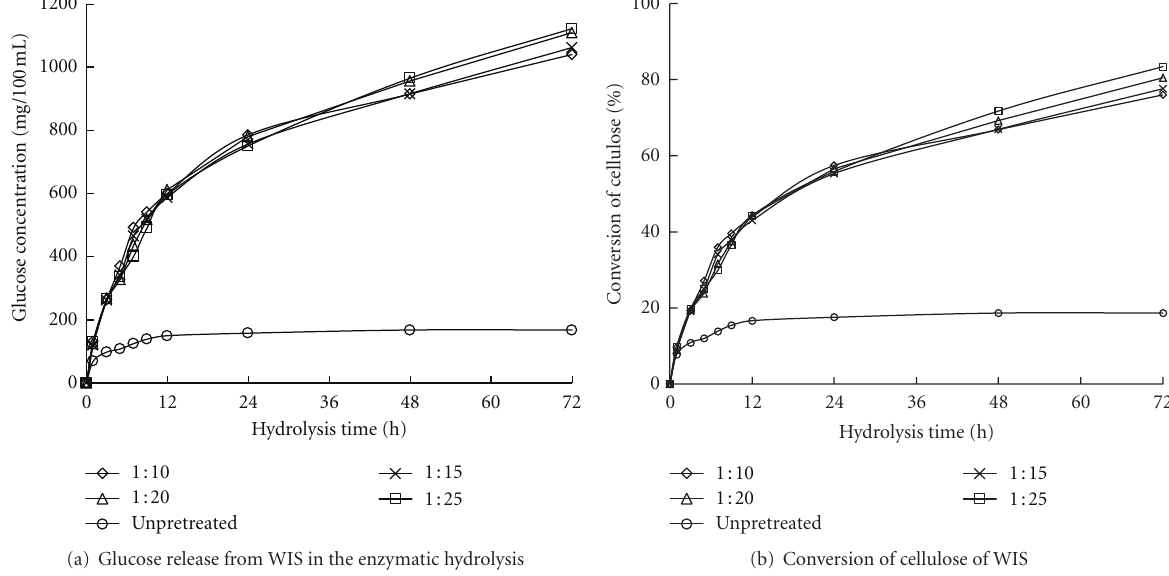
Figure 2: E ff ect of solid-to-liquid ratio on enzymatic hydrolysis of the WIS from the pretreated reed. ∗ LHW pretreatment: 180 ◦ C for 20 min. ∗∗ Enzymatic hydrolysis: 30FPU/g oven-dried WIS, pH 4.8, at 50 ◦